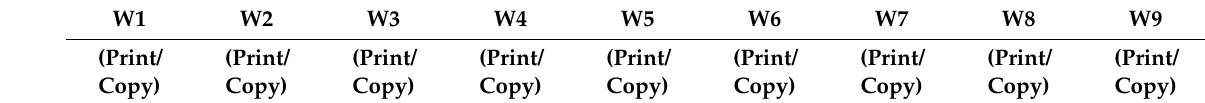
Table 6. Reference (REF) scenario results —printed/copied page volume of each printing device.